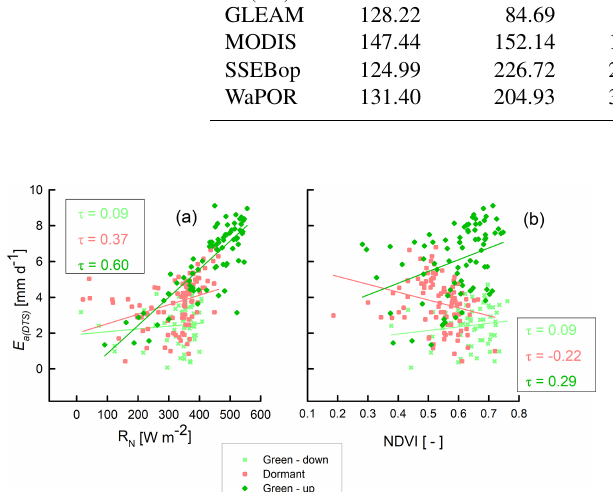
Figure 10. Kendall correlation of E a ( DTS ) with R N and NDVI in the green-down, dormant, and green-up phenophases of the miombo woodland at Mpika site,